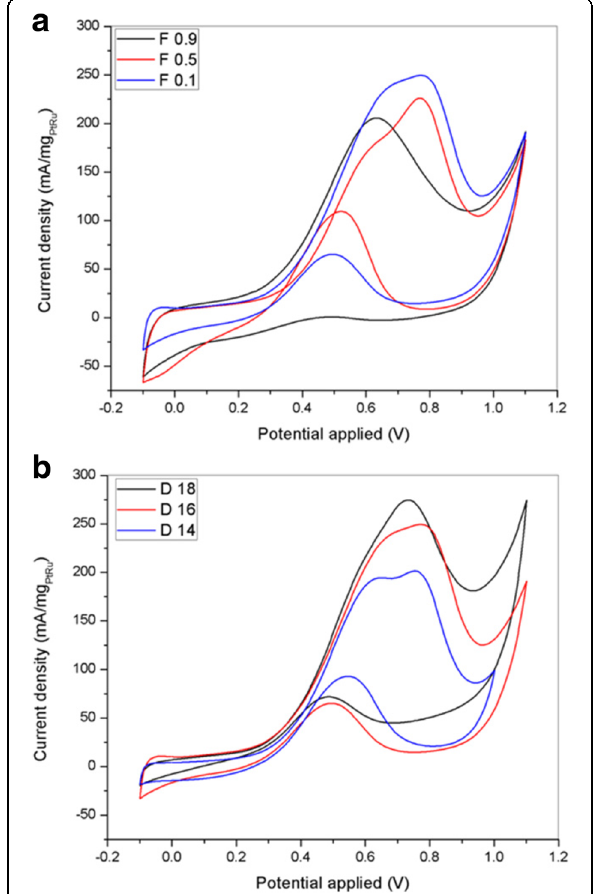
Fig. 13 Cyclic voltammograms for PtRu/TiO 2 -CNF with different a flow rate and b DTC of the catalyst support in 2 M methanol and 0.5 M H 2 SO 4 at the scan rate of 50 mVs −